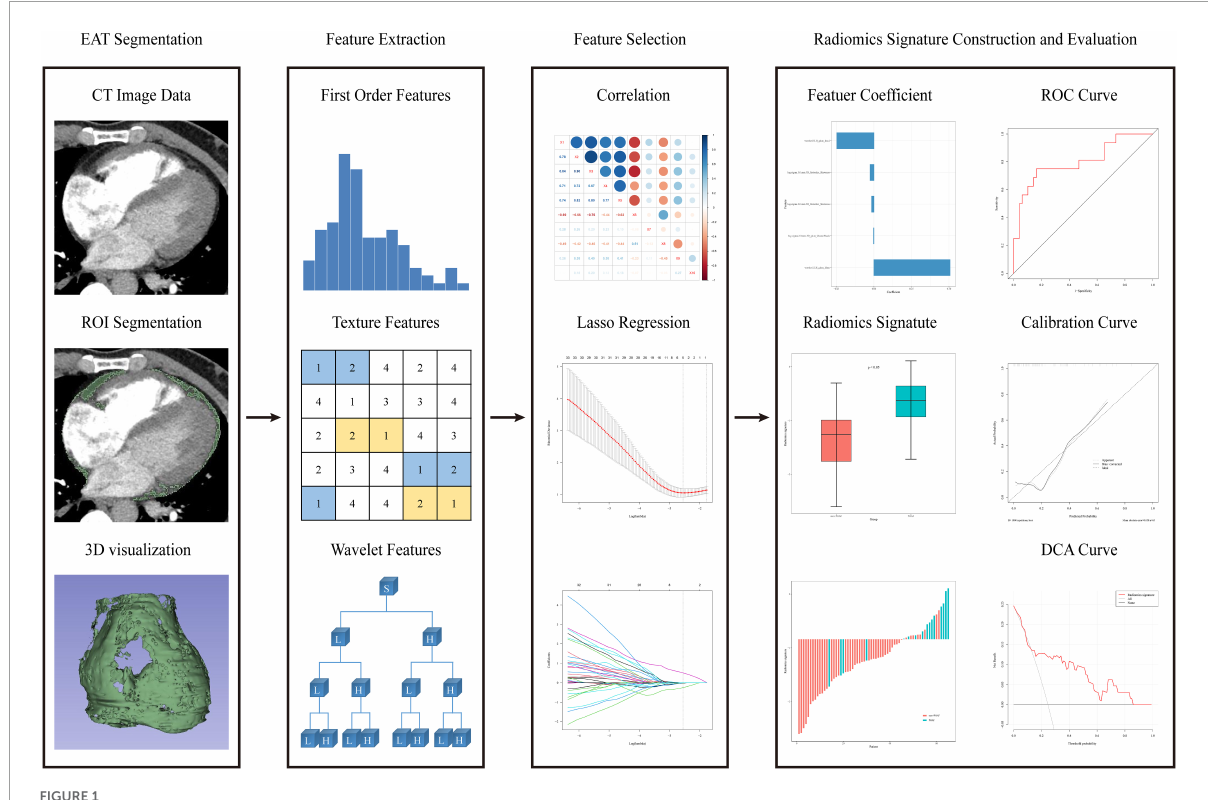
FIGURE1 Flowchart of the radiomics analysis